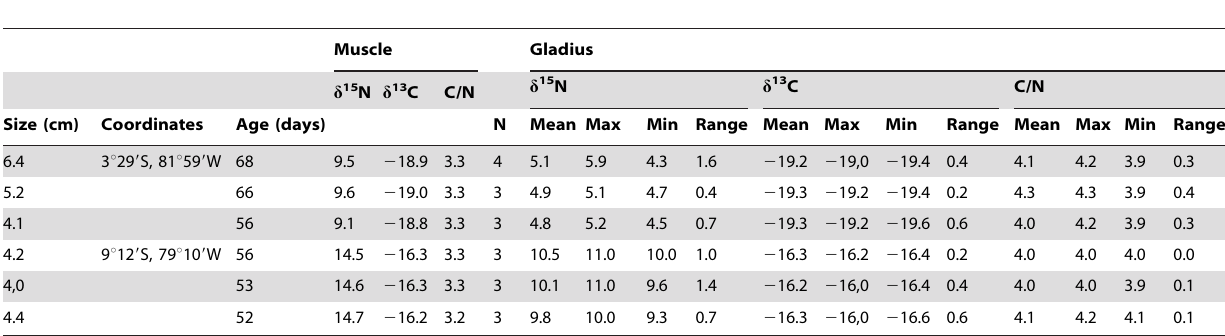
Table 2. Age, size, isotopic values ( 6 s.d) and C/N mass ratios of three small individuals per latitude.